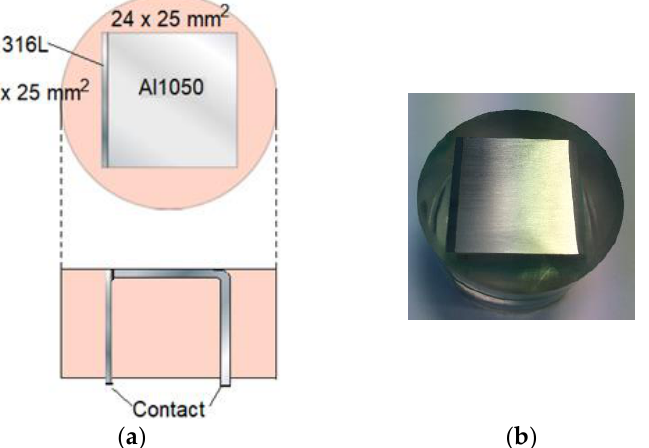
Figure 6. Specification experimental calibration cell. Upper part ( a ): top view of cell. Lower part ( a ): view from the side. ( b ) Top view photo of calibration cell.